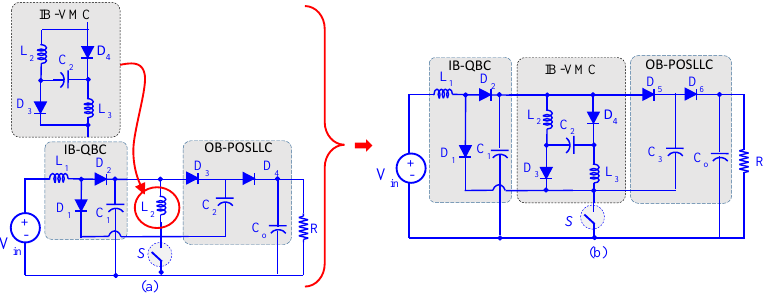
Figure 2. ( a ) The composition of the proposed converter, ( b ) the proposed